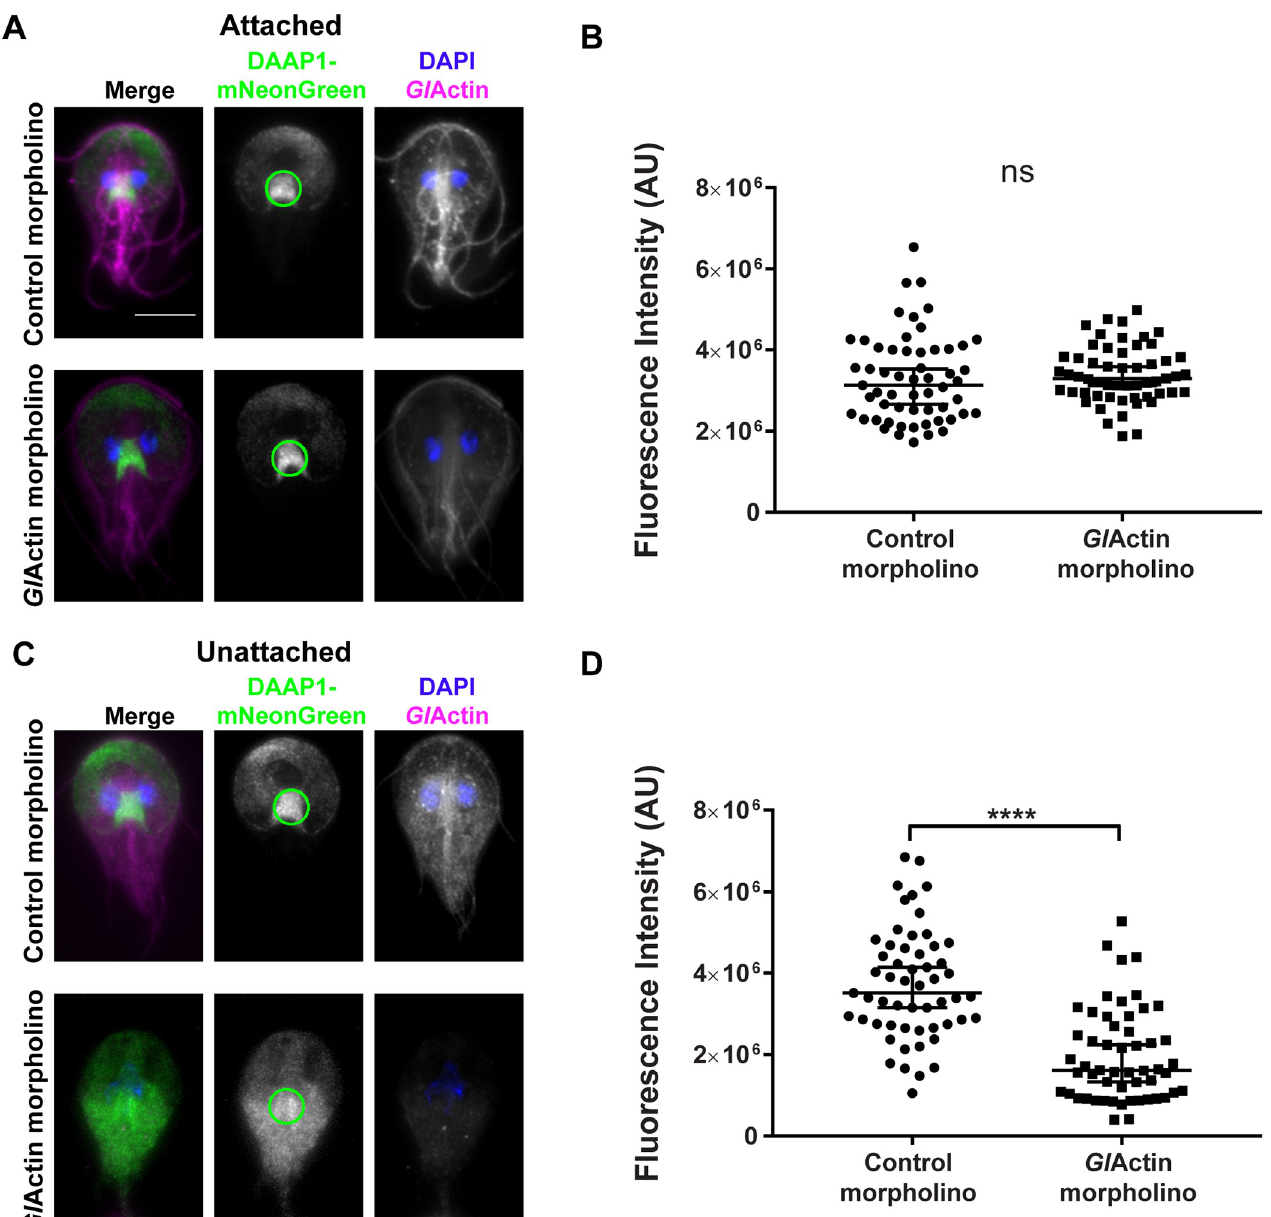
Fig 3. DAAP1 loading onto the ventral disc requires Gl Actin. A) Representative images of attached cells 24 hours after treatment with either an anti- Gl Actin or control morpholino. Fluorescence intensity of DAAP1 at the ventral groove (see green circle) was measured at the brightest section in each stack. Gl Actin shown in magenta, mNeonGreen-DAAP1 in green, DAPI in blue. Scale bar denotes 5 μ m. B) A two-tailed Mann-Whitney test indicated that this difference was not statistically significant, (N Control = 57, N = 55), P = 0.227. Median and 95% confidence interval shown. Median of control = 3131445. Median of Gl Actin-depleted = 3298353. Two and four outliers were detected by Tukey Fence, k = 1.5 in the control and Gl Actin-depleted condition respectively and were not included in the analysis. C) Representative images of unattached cells 24 hours after treatment with either an anti- Gl Actin or control morpholino. Fluorescence intensity of DAAP1 at the ventral groove (see green circle) was measured at the brightest optical section in each stack. D) A two- tailed Mann-Whitney test indicated that this difference was statistically significant, (N Control = 55, N = 54), P < 0.0001. Median and 95% confidence interval shown. Median of control = 3508064. Median of Gl Actin-depleted = 1609904. Four outliers were detected by Tukey Fence, k = 1.5 in the Gl Actin- depleted condition and were not included in the